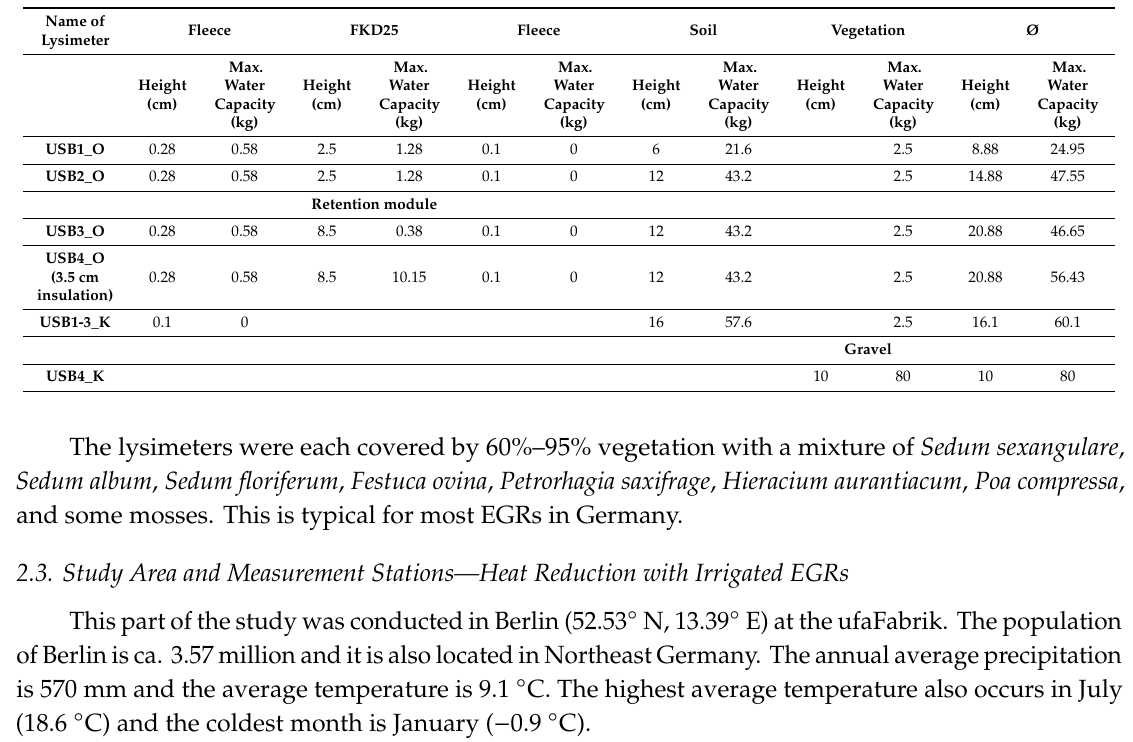
Table 2. Description and construction of the small scale lysimeters.